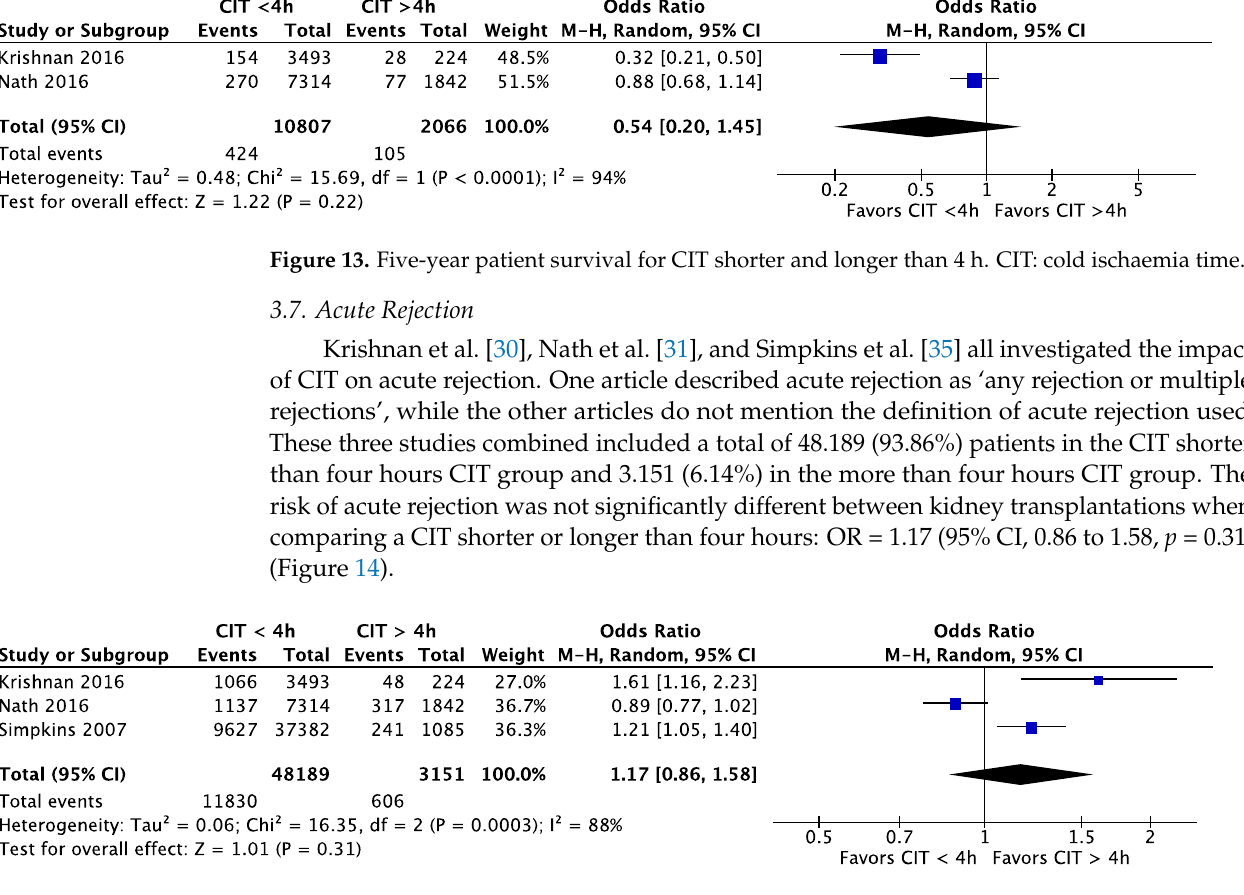
Figure 14. The incidence of acute rejection for CIT shorter and longer than 4 h. CIT: cold ischaemia